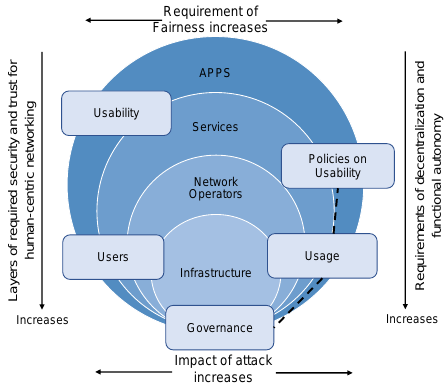
Figure 5. An illustration of human-centric security pillars for networks [12]